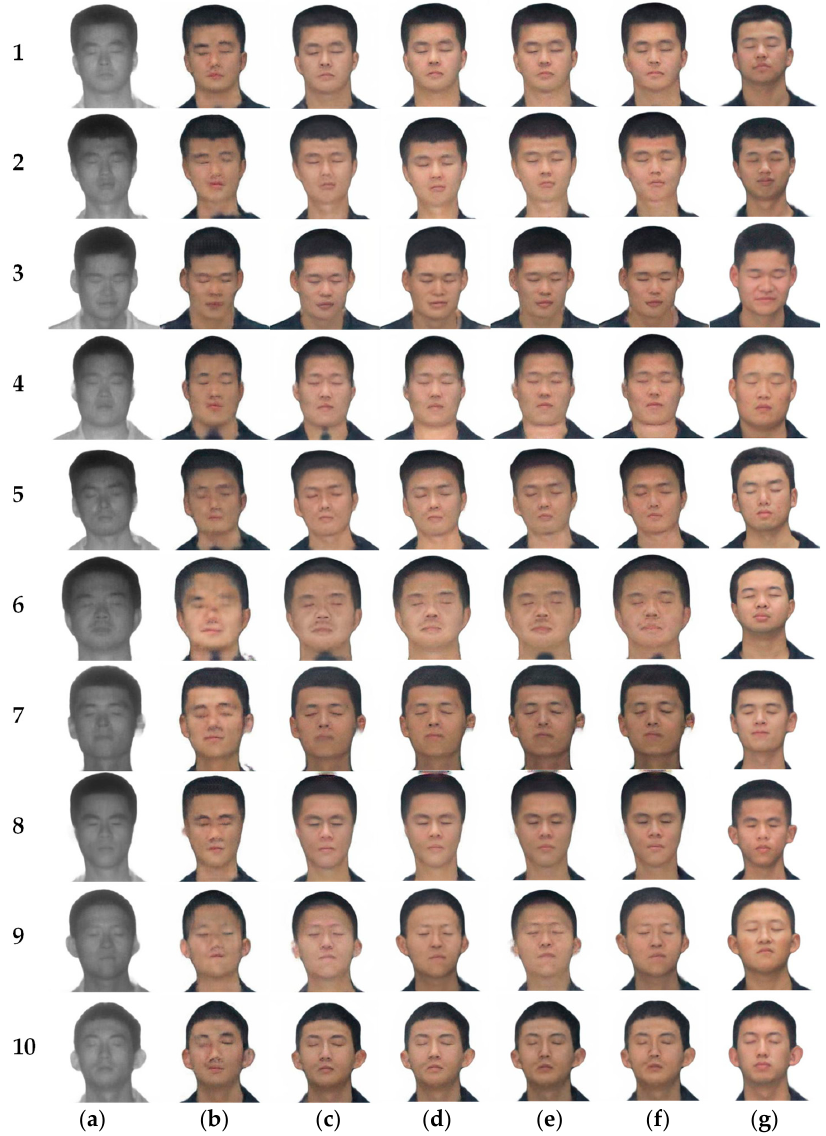
Figure 12. Ablation experiments. ( a ) Laser images. ( b ) CycleGAN. ( c ) CycleGAN+SND. ( d ) CycleGAN+SND+ 𝐿 𝑌 . ( e ) CycleGAN+SND+ 𝐿 𝑖𝑑𝑒𝑛𝑡𝑖𝑡𝑦 . ( f ) SN-CycleGAN (Ours). ( g ) Ground truth.